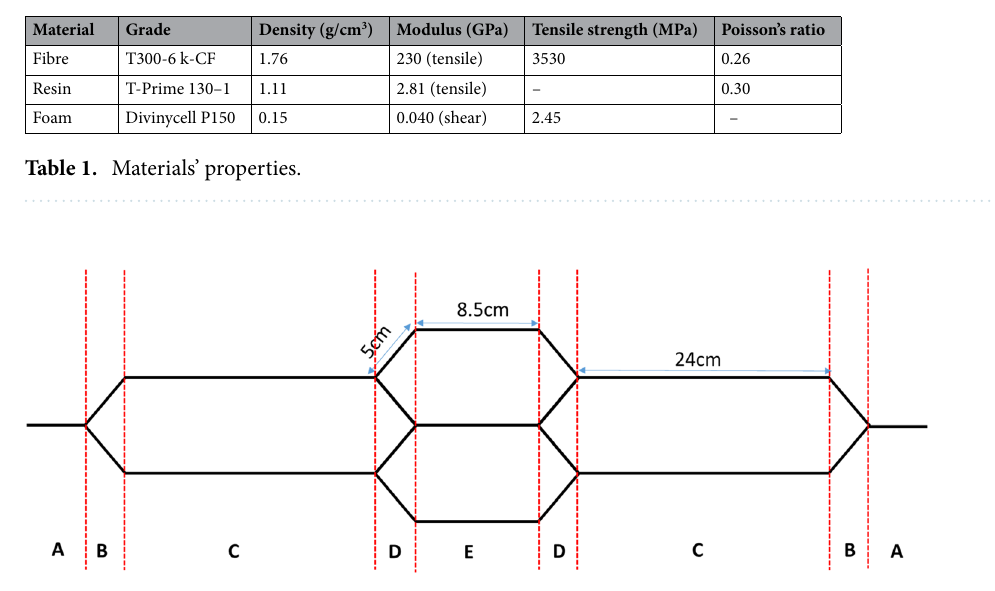
Figure 2. Honeycomb structure, ( A , B , C , D , E ) are plain weaves of different number of layers; 1-layer ( A ), 2-layer ( B , C ), 4-layer ( D ) and 3-layer ( E